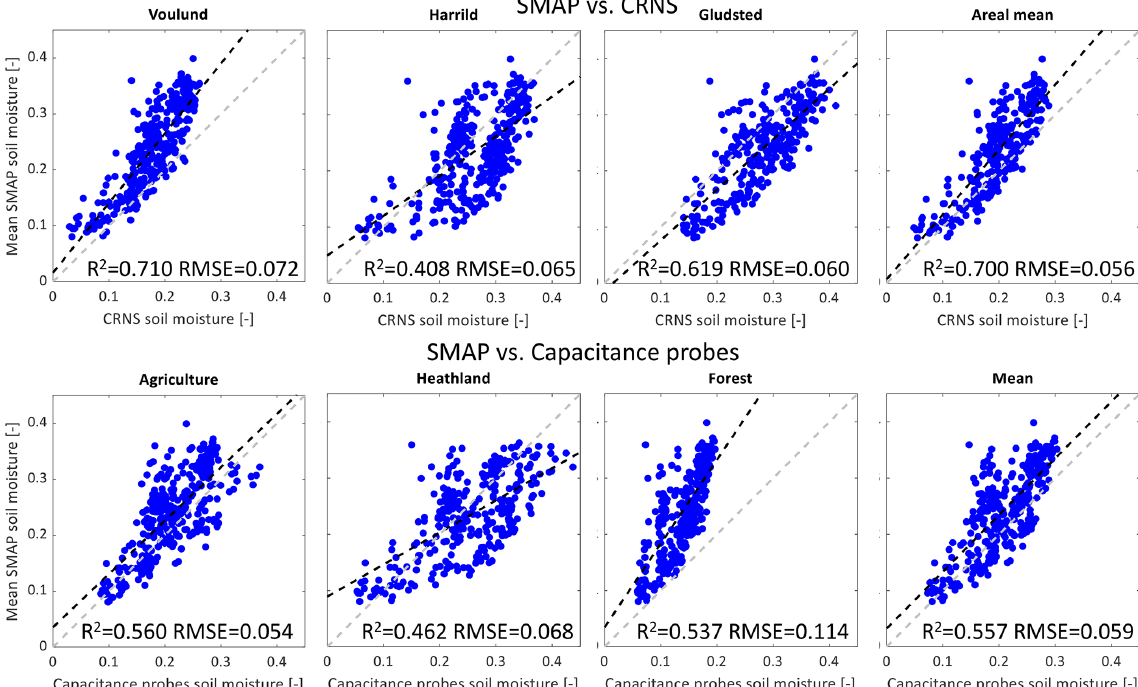
Figure 3. Upper panels: scatter plots of soil moisture estimates by SMAP versus in situ soil moisture estimates by CRNS at the different field sites at Voulund (agriculture), Harrild (heathland) and Gludsted (forest) and as a weighted areal mean. Lower panels: scatter plots of soil moisture estimates by SMAP versus in situ soil moisture estimates by capacitance probes for different land use types and the mean. Dotted black line shows the linear regression and dotted grey line shows the 1 : 1 line. R 2 and RMSE between soil moisture estimates derived by SMAP and CRNS or capacitance probes are indicated in each